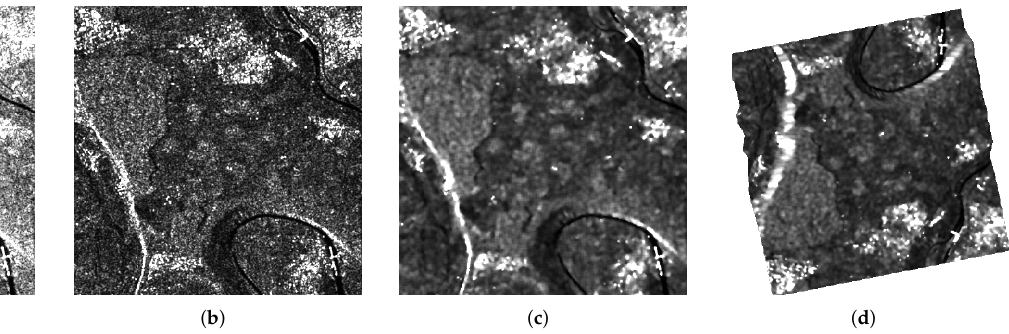
Figure 4. Example of intermediate processing outputs for a Sentinel-1 SAR image (VV polarisation): ( a ) Subset of the original VV band, ( b ) Radiometrically calibrated VV band, ( c ) Speckle filtering output, ( d ) Terrain-corrected VV band.